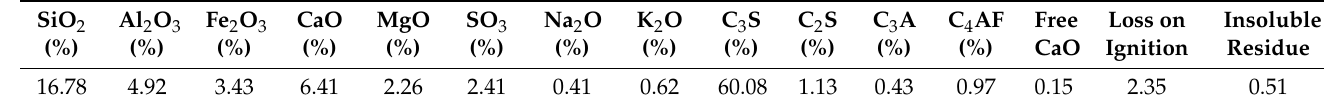
Table 2. Chemical properties of cement.